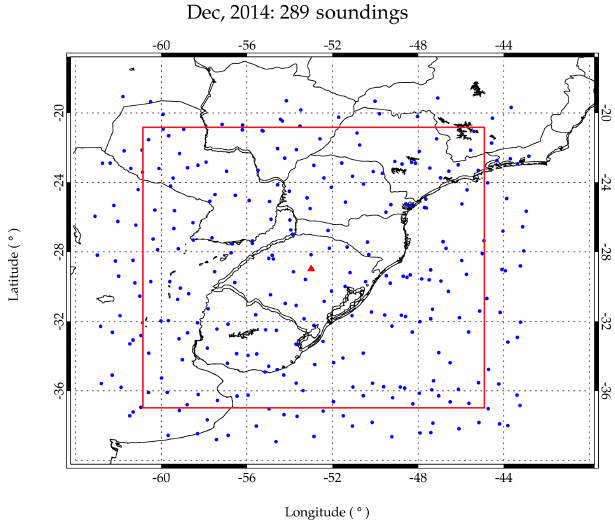
Figure 1. Example of SABER/TIMED sounding locations (blue dots) during December 2014, over the Santa Maria location (red triangle) within a grid of ± 10 ◦ in latitude and longitude (lat/long). The red box corresponds to the main and smaller region delimited within ± 7.5 ◦